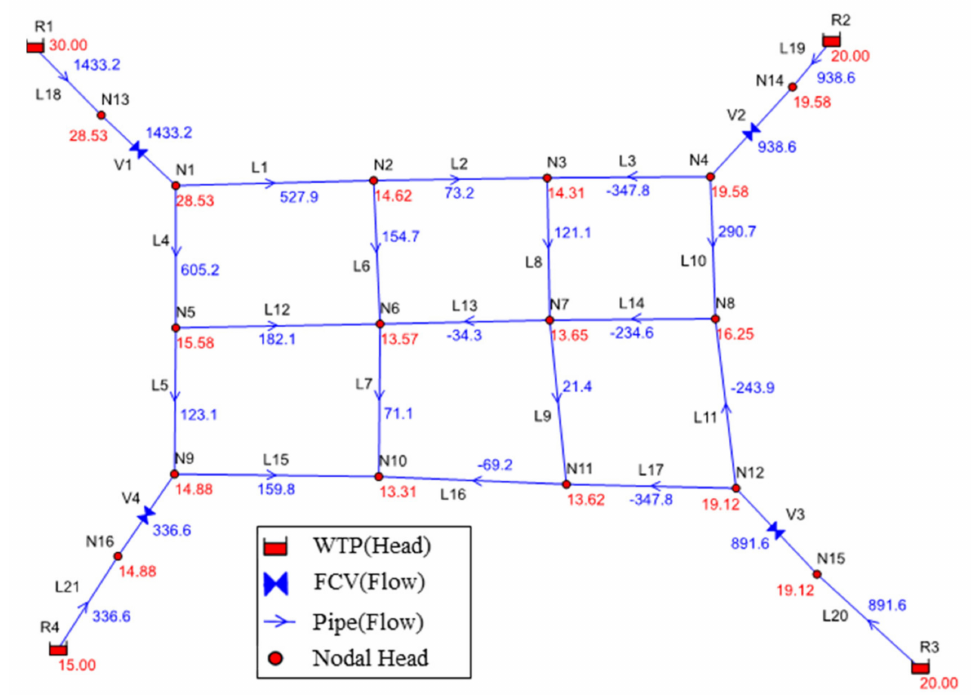
Figure 4. Case 1 before the optimization of the hydraulic distribution of the WDS. Table 2. Case 1 costs of water discharge in each WTP before optimization.